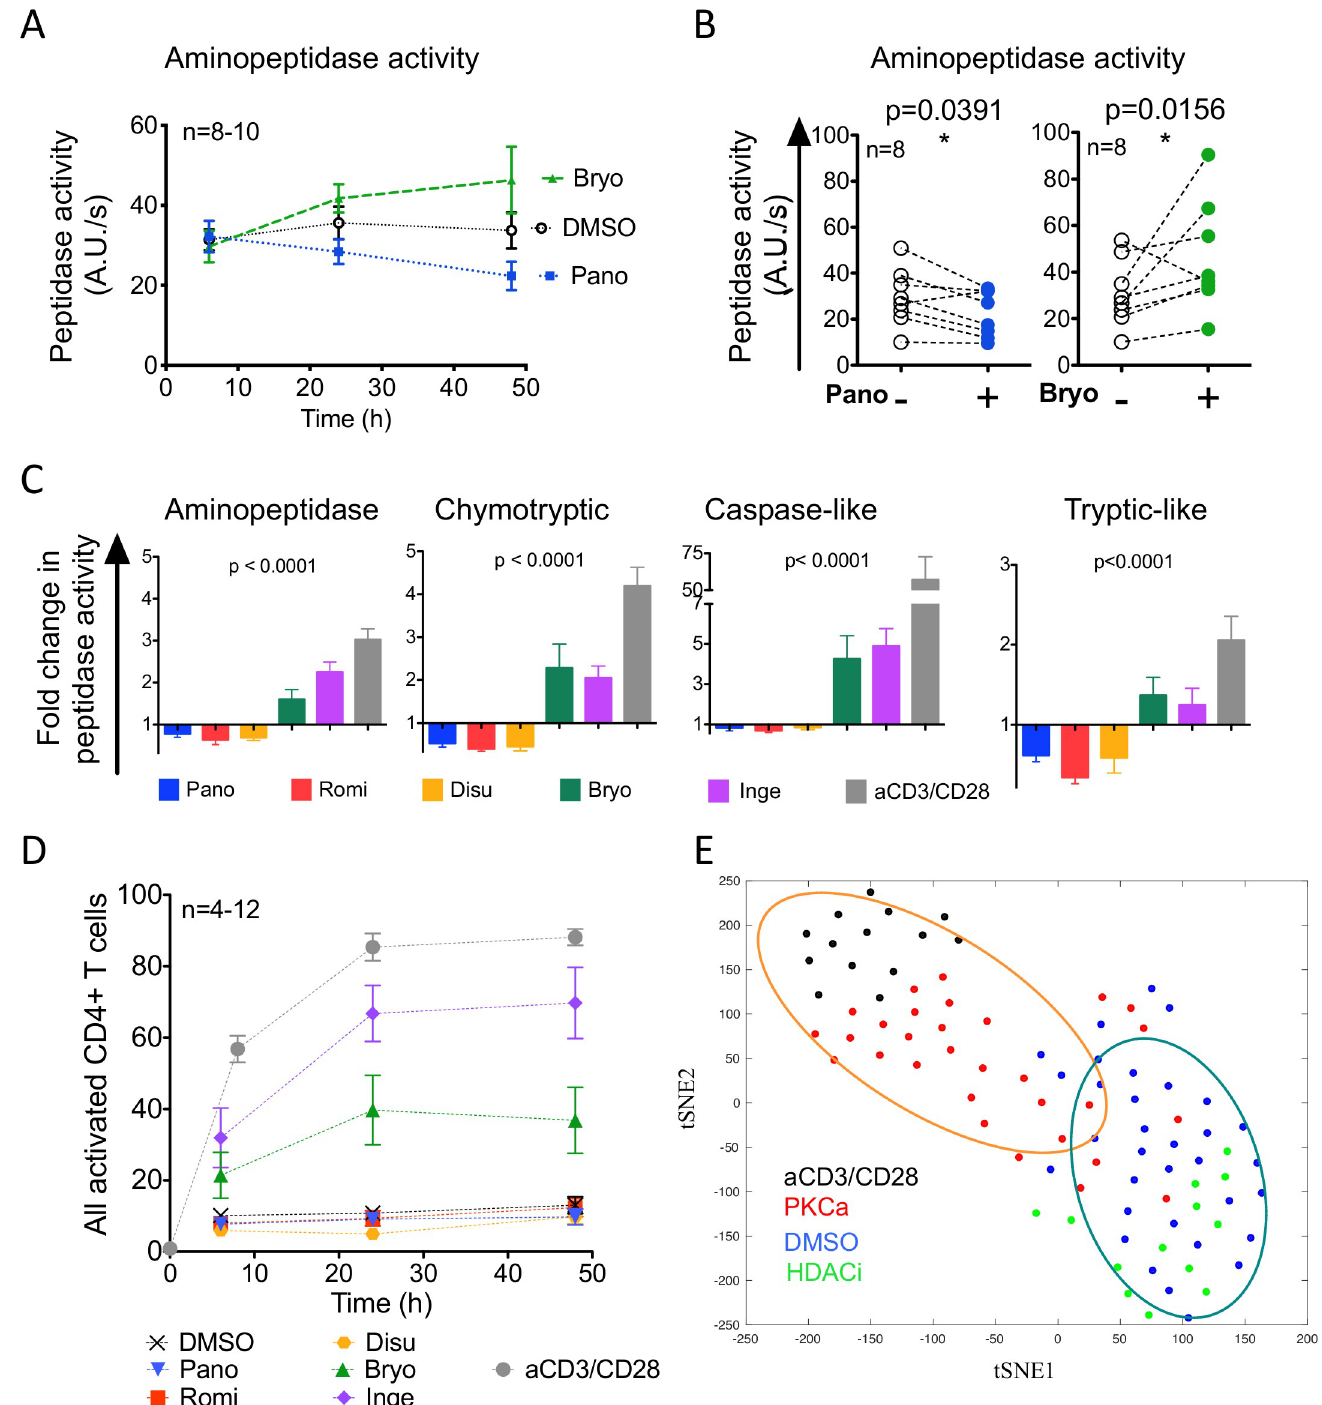
Fig 1. Different classes of LRA alter cytosolic peptidase activities. A. Aminopeptidase hydrolytic activity in primary CD4 T cells of healthy donors (n = 8–10) at 6, 24 and 48 h after treatment with DMSO (open circles), Bryostatin (green triangles) or Panobinostat (blue squares). B. Aminopeptidase hydrolytic activity in paired DMSO- (open circles) and Panobinostat-treated (blue circles, left) or DMSO- and Bryostatin-treated (green circles, right) primary CD4 T cells at 48 h post- treatment (n = 8 healthy donors). Wilcoxon matched-pairs signed-rank t tests analysis. C. Fold change in aminopeptidase, proteasomal chymotryptic, caspase-like, tryptic-like hydrolytic activities in LRA-treated over DMSO-treated cells at 48 hours: Panobinostat- (blue), Romidepsin- (red), Disulfiram- (orange), Bryostatin- (green), Ingenol- (purple) or aCD3/CD28-treated samples (n = 6–16). One-Way ANOVA Kruskal-Wallis tests on the 6 groups and p-values are reported. D. CD25 and CD69 surface levels were monitored by flow cytometry in primary CD4 T cells at 6, 24 and 48 h post treatment with DMSO (black crosses), Panobinostat